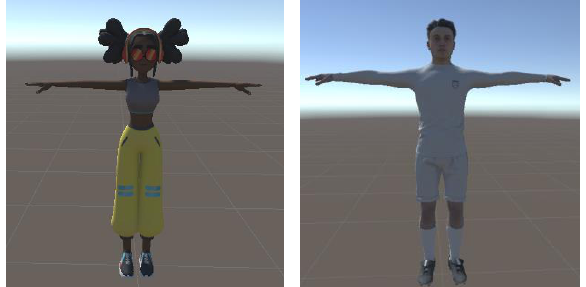
Figure 14. Examples of the Mixamo